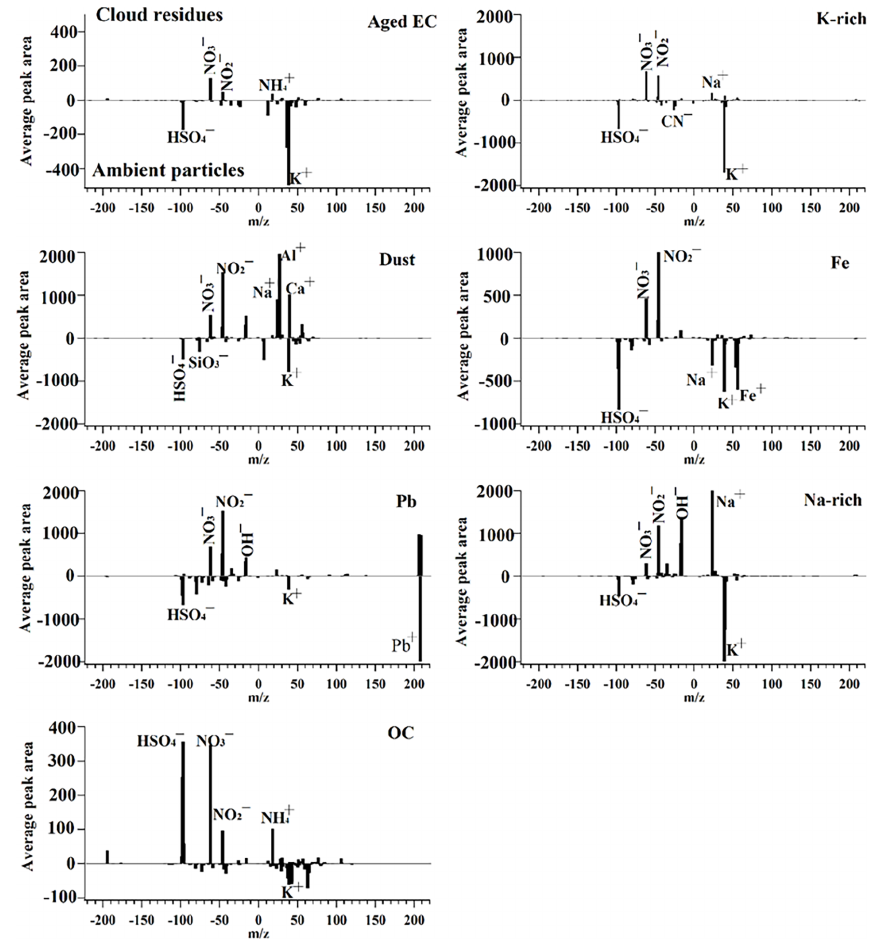
Figure 8. Mass spectral subtraction plot of the average mass spectrum corresponding to cloud residues minus ambient particles. Positive area peaks correspond to higher abundance in cloud residues, whereas negative area peaks show higher intensity in ambient